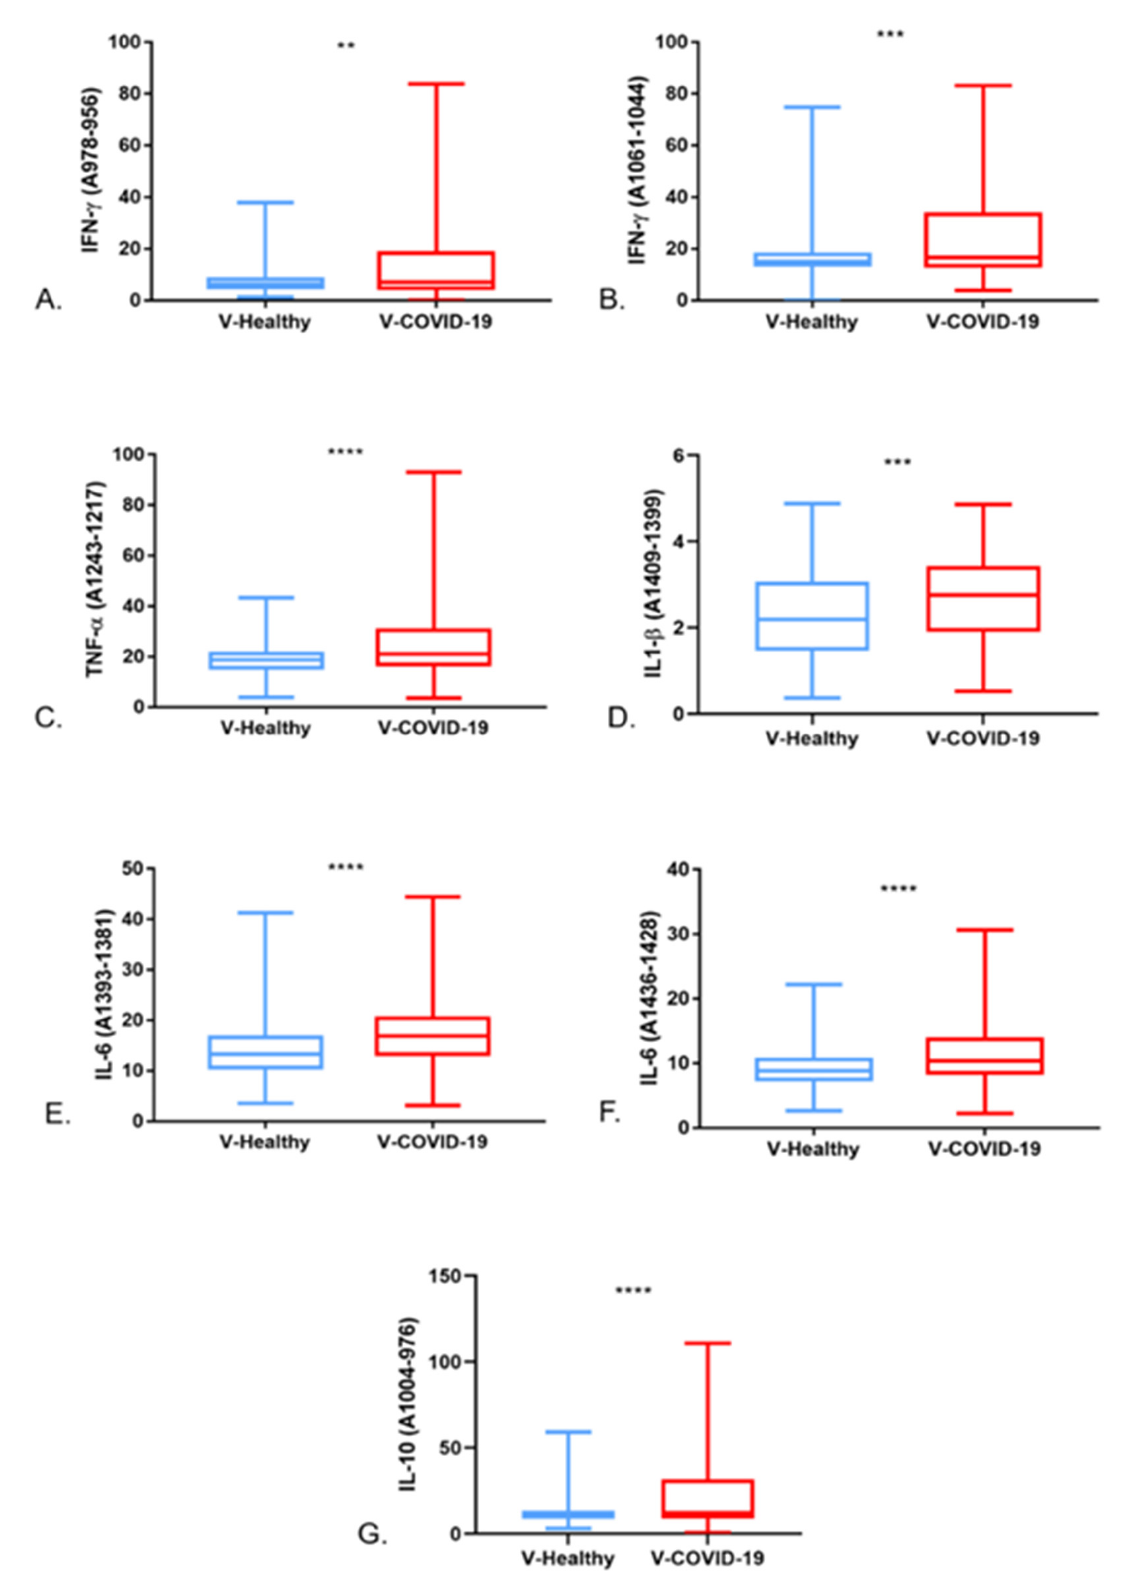
Figure 5. Integrated areas of the regions related to cytokines. IFN- γ ( A and B ), TNF- α ( C ), IL-1 β ( D ), IL-6 ( E and F ), and IL-10 ( G ). ** p < 0.05, *** p < 0.005 and **** p < 0.0005. ( E , F ), and IL-10 ( G ). ** p < 0.05, *** p < 0.005 and **** p <